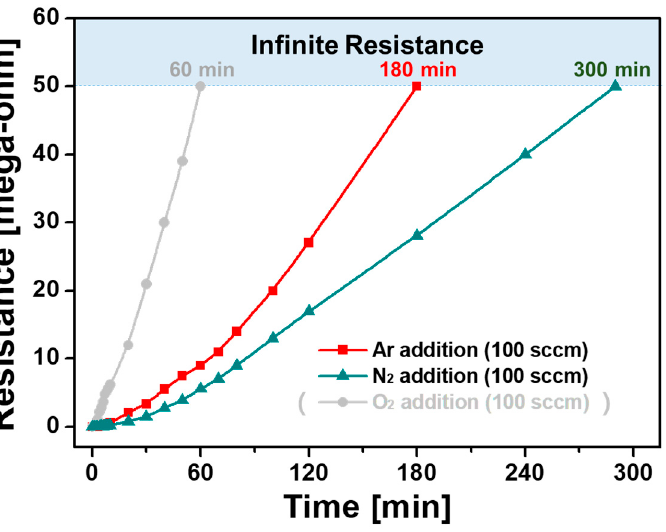
Figure 9. Electrical resistance of I 2 -doped PANI fi lms prepared with di ff erent additional gases.